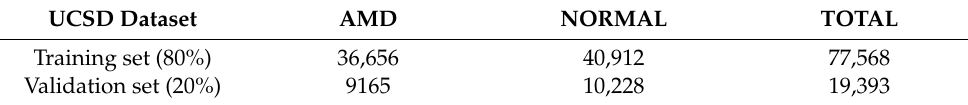
Table 1. Data distribution for training and validation using the UCSD